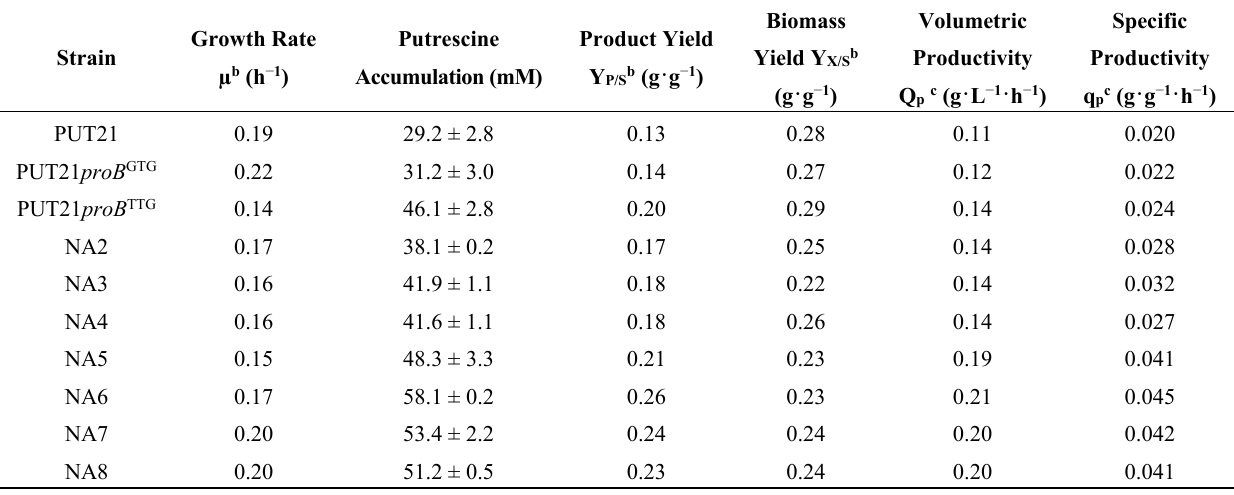
Table 2. Growth Rates and Putrescine Production Parameters Obtained with Various Engineered C. glutamicum Strains a